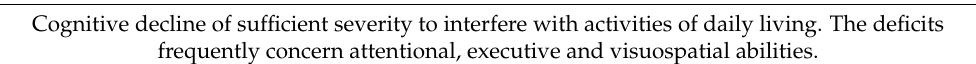
Clinical Characteristics Essential